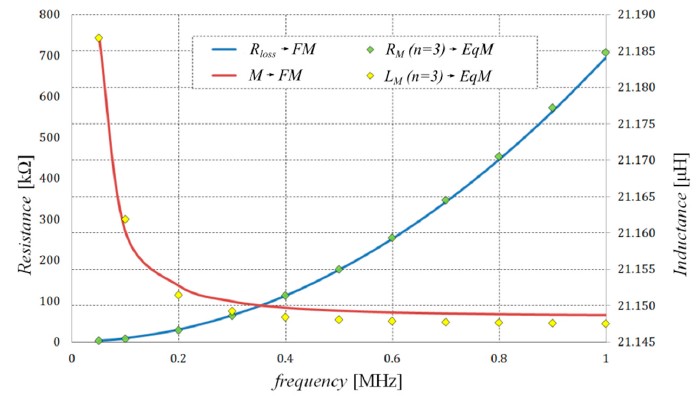
Figure 6. Comparison of the equivalent impedance components obtained for the magnetizing branch of the transformer equivalent circuit using the second-order Cauer circuit ( n = 3) and field model. Calculated by means of the EqM, the current waveforms I R and I T were compared with